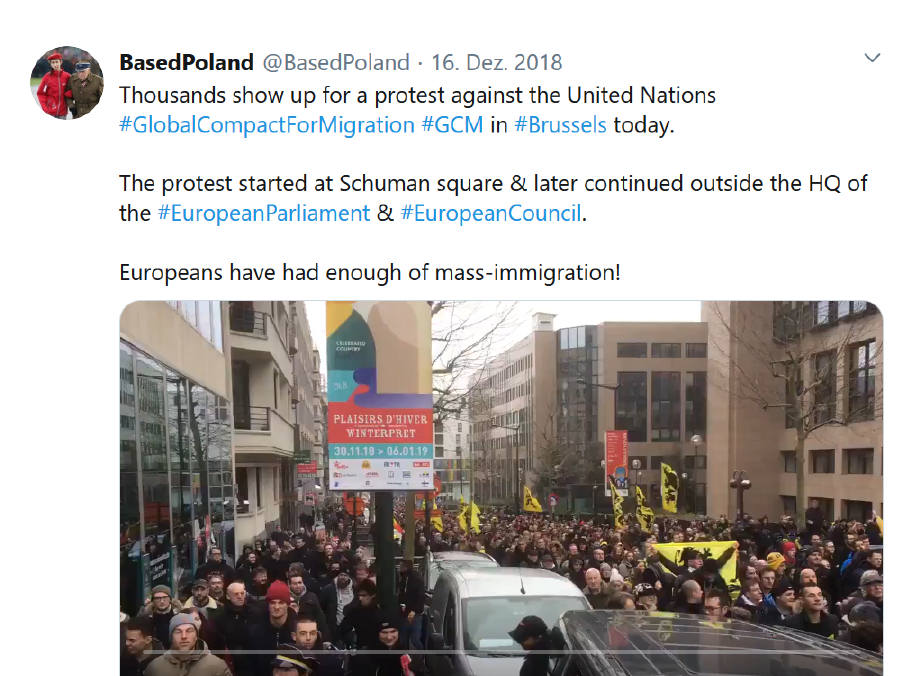
Figure 3. Tweet with a video of demonstrators against the GCM. Source: BasedPoland